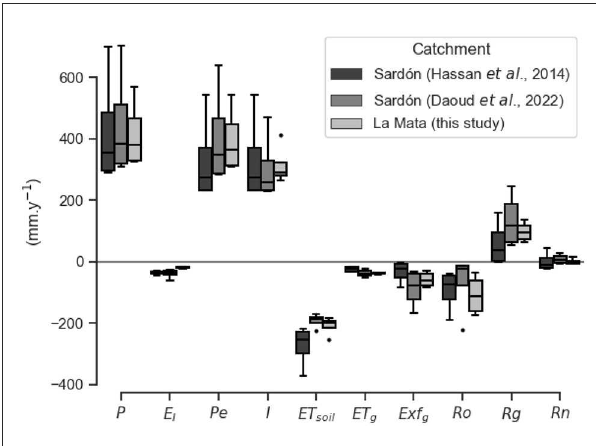
FIGURE11 Comparison of the main water fluxes (mm.y − 1 ) of this La Mata study with corresponding water fluxes computed by Hassan et al. (2014) and Daoud et al. (2022) in the Sardón catchment, all presented for the common period of four hydrological years 2009–2012. See Figure 2 for other